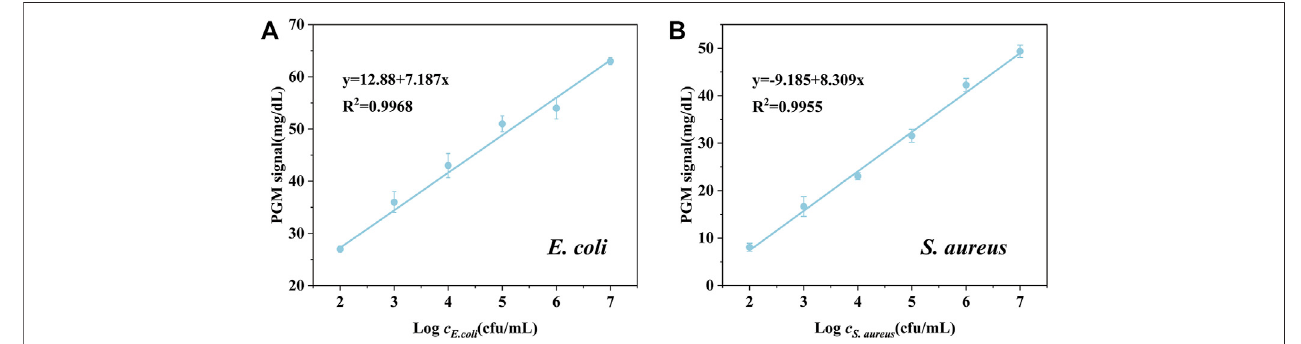
FIGURE 6 | PGM signal against the different concentrations of E. coli (A) and S. aureus (B) .